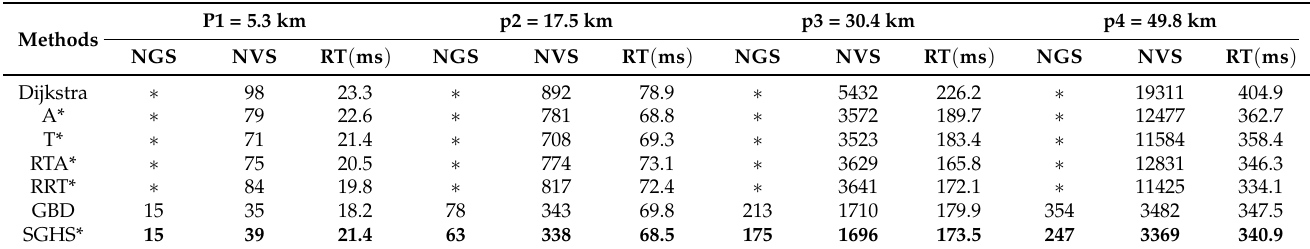
Table 6. Different of Effect Based Different Distributions with Four